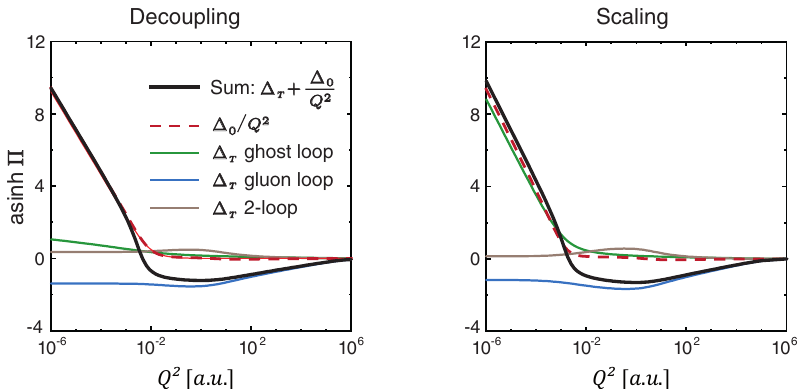
Figure 3: Gluon self-energy contributions for the decoupling and scaling case [ 5 ]